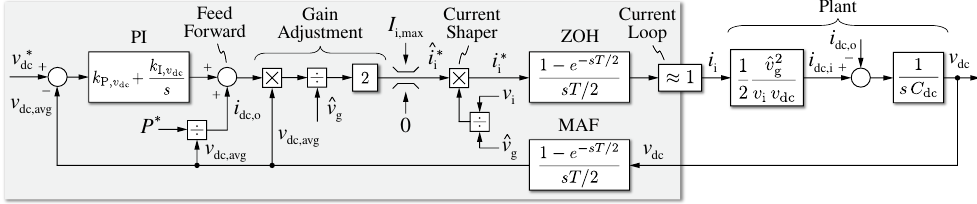
Figure 9. Detailed block diagram of the PFC DC-link voltage ( v dc ) control